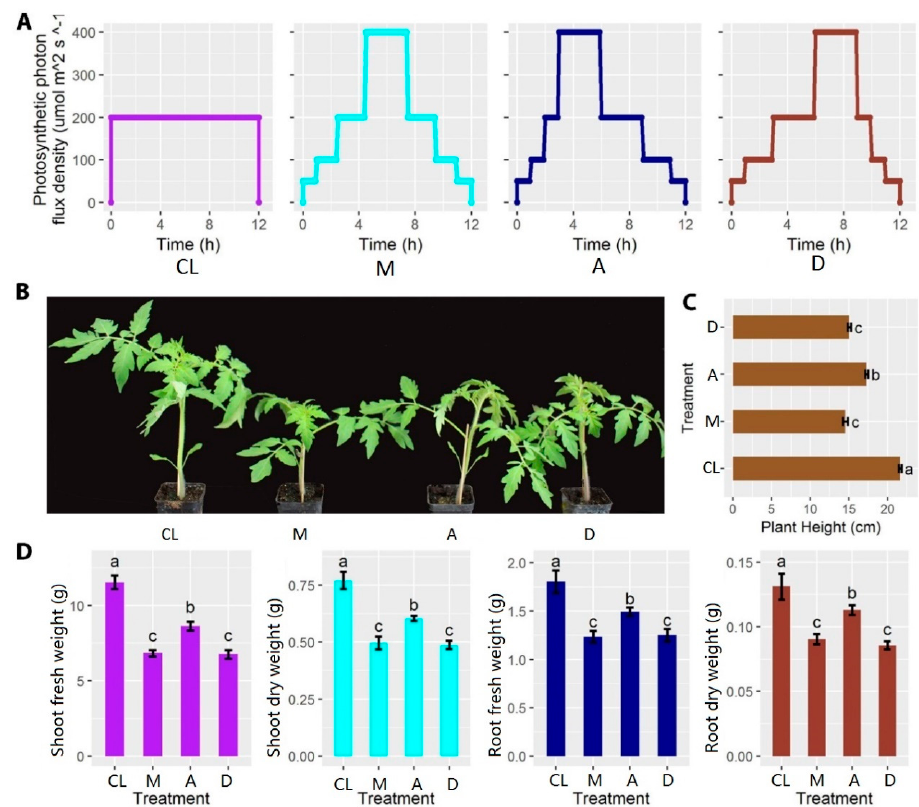
Figure 1. Experimental design and measurements of fresh and dry weight of shoots and roots, respectively. ( A ) Light distribution patterns of control (CL), treatment 1 (M), treatment 2 (A), and treatment 3 (D). ( B ) Morphological comparisons between different treatments after five weeks ( n = 8). ( C ) Comparison of plant height between different treatments after five weeks. ( D ) Comparisons of shoot fresh weight, shoot dry weight, root fresh weight, and root dry weight between different treatments after five weeks. Different lowercase letters indicate a significant difference among the same treatments ( p < 0.05). Each bar represents the mean ± SE (standard error) of eight biological replicates.